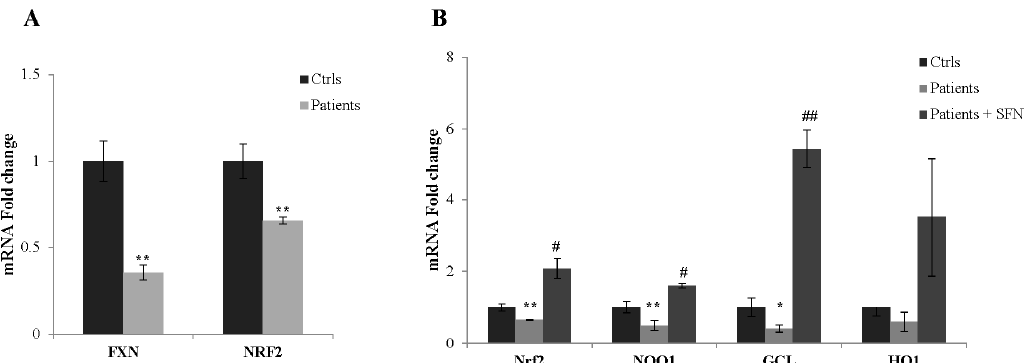
critical for maintaining the glutathione homeostasis in cells (B).